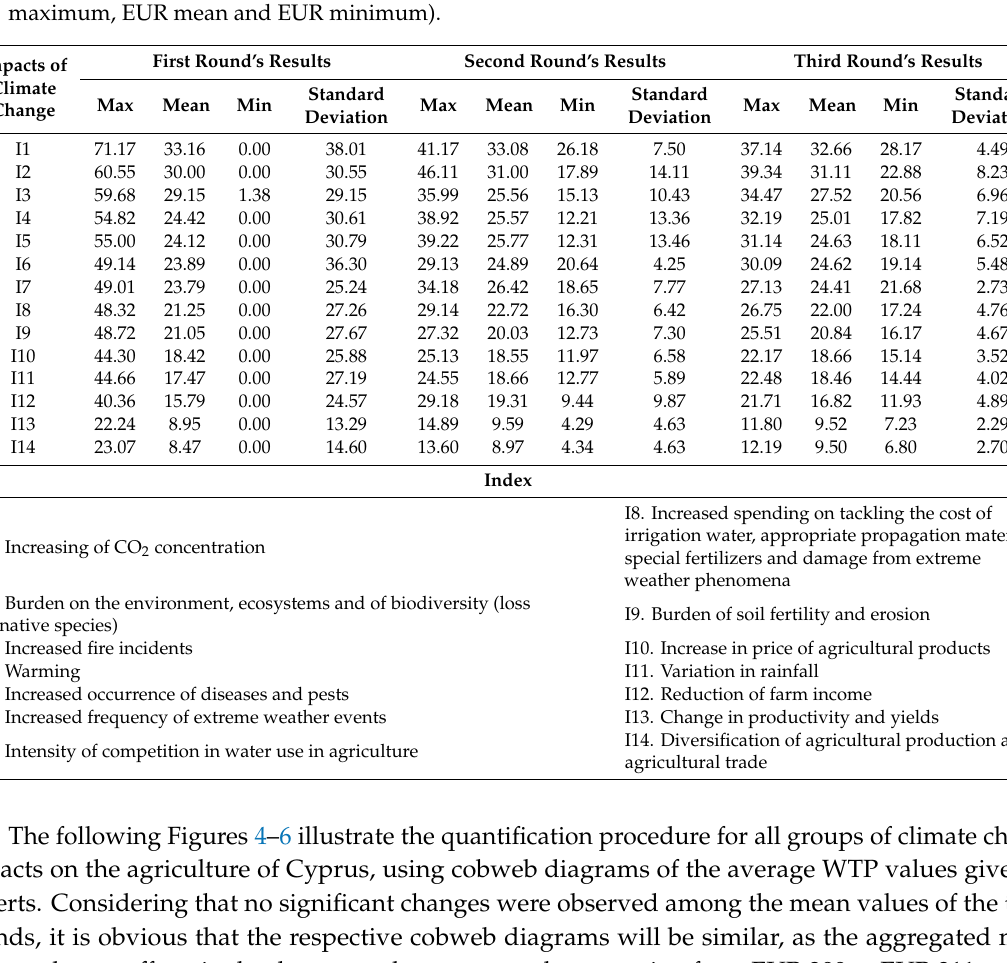
Table 1. Rating results for the Delphi first, second and third round’s Willingness-To-Pay values (EUR maximum, EUR mean and EUR minimum).